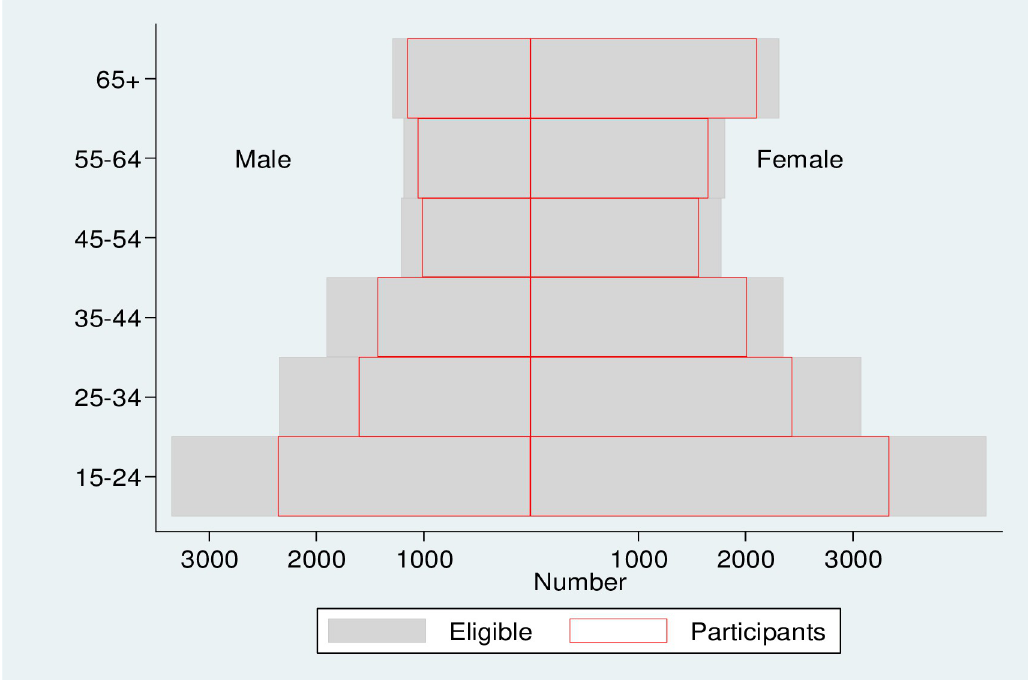
Fig 3. Age and sex distribution of eligible and participant populations.